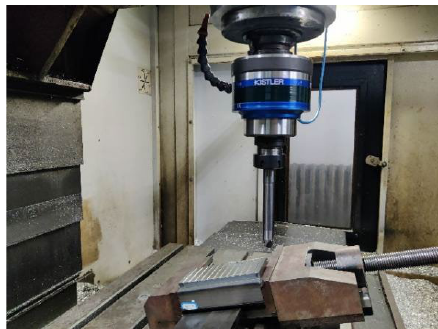
Figure 7. workpiece clamping. Figure 7. Workpiece clamping.